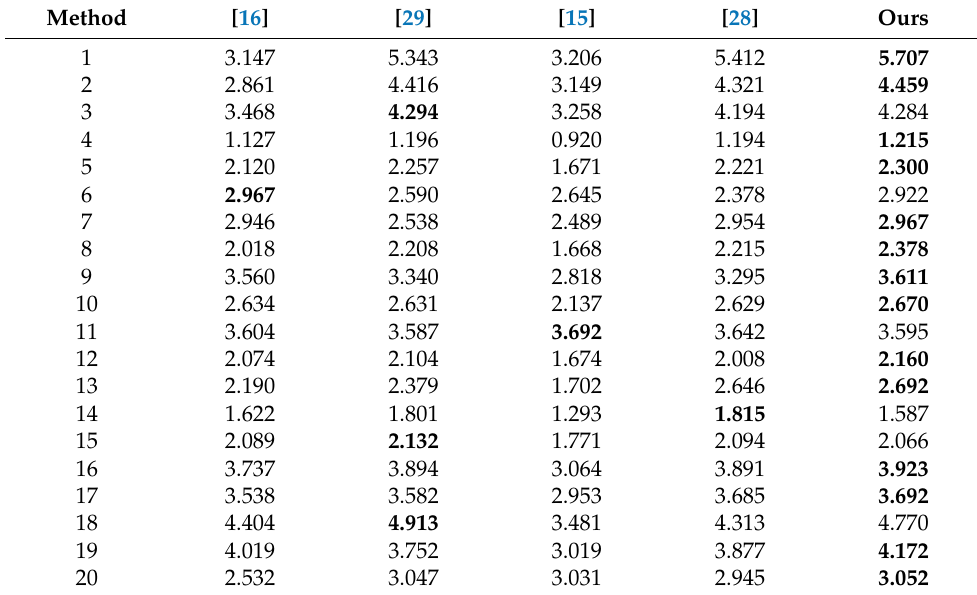
Table 3. Objective evaluation results of